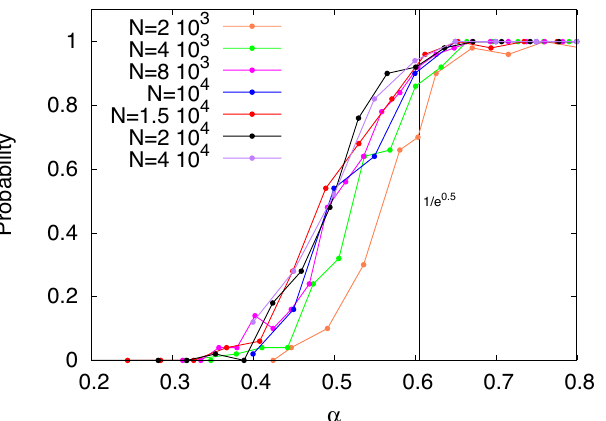
Figure 11. Probability of solution vs α using SM[1] with early stopping, at graph sizes from 2000 to